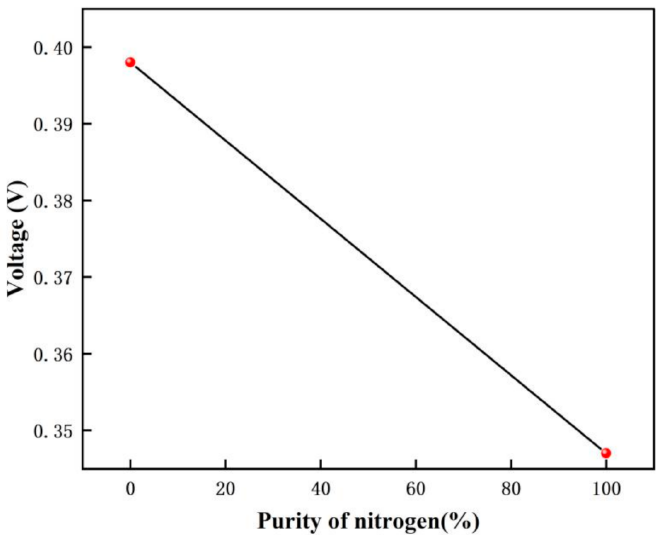
Figure 25. The voltage response graph for different purity nitrogen environments.